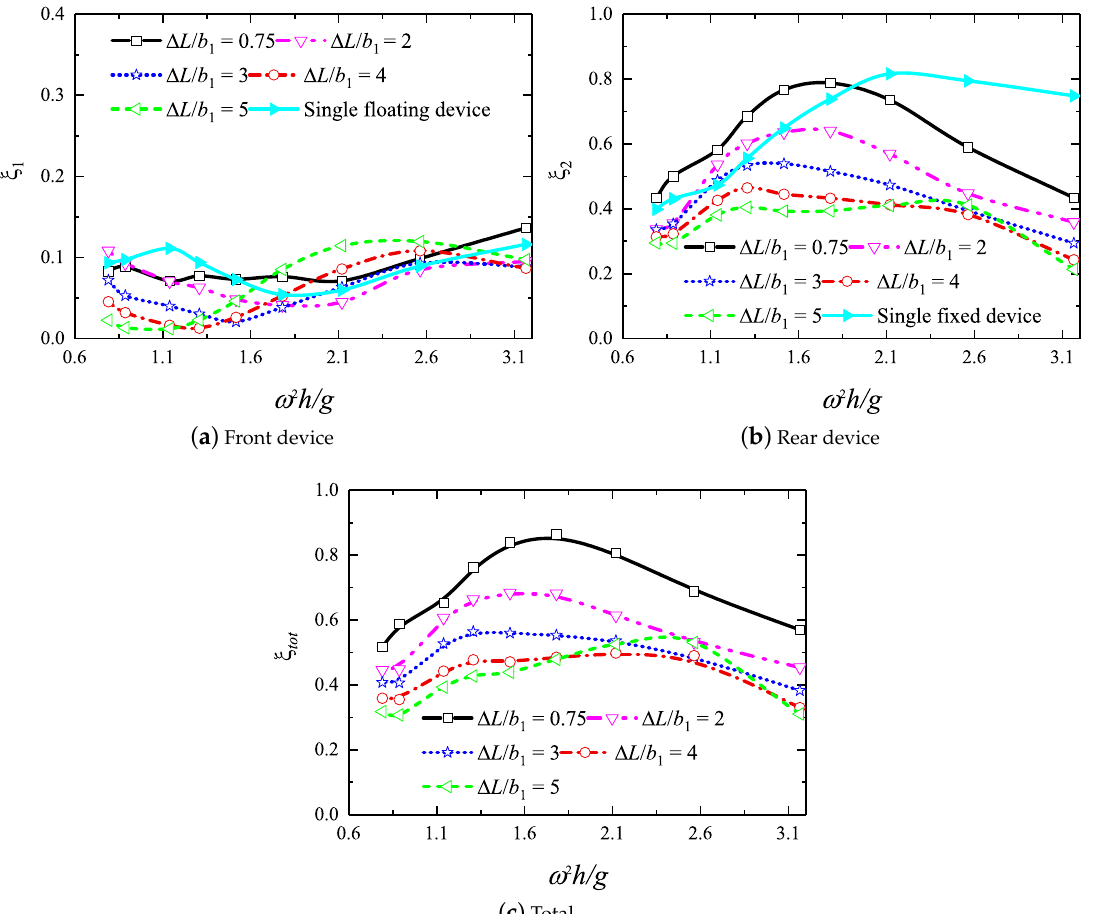
Figure 17. Effects of the small intervals on the hydrodynamic efficiencies. In all cases, b 2 / b 1 = 2, d 1 = d 2 = d 3 = 0.05 m, and K =